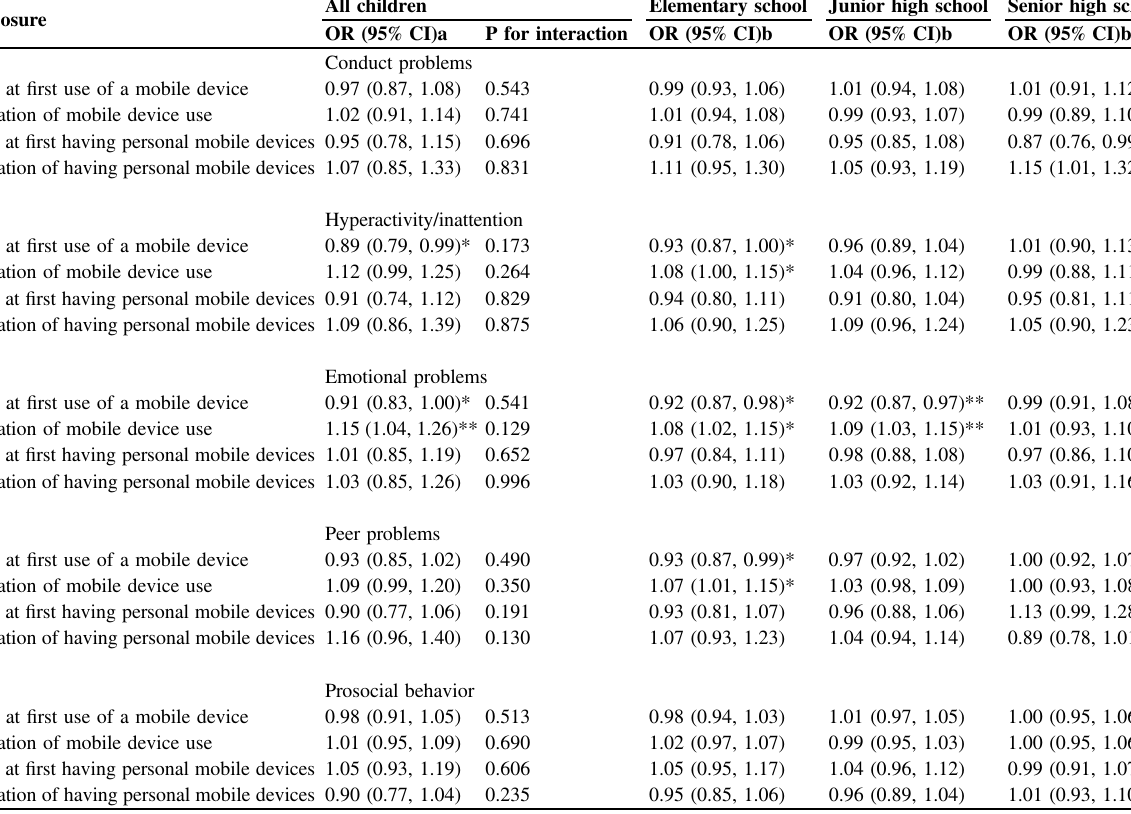
Table 6 OR of subscale of SDQ according to child ’ s mobile device usage.